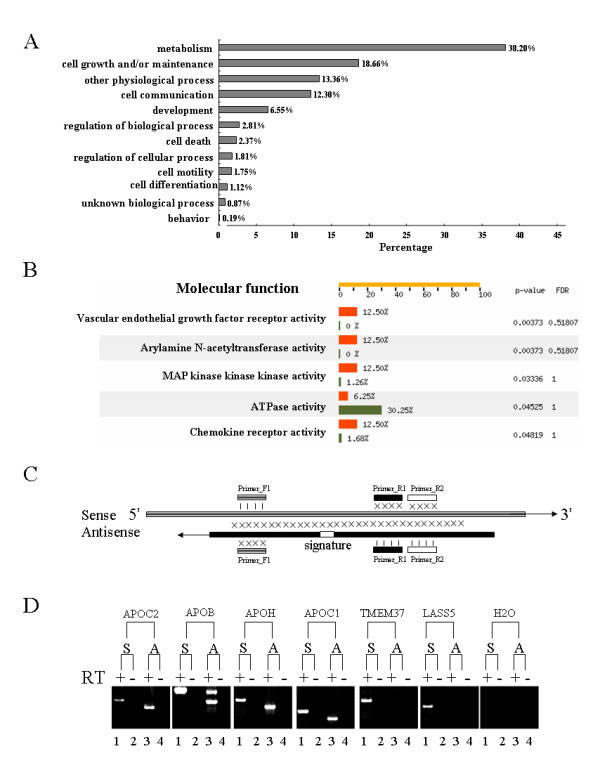
Functional categories of genes with antisense transcripts and confirmation of sense-antisense pairs of various genes expressed in human hepatocytes. A. Genes with antisense transcripts were assigned into different functional categories according to the Gene Ontology (GO) database. B. Functional over- or under-representation of GO subcategories in genes with antisense transcripts was statistically analyzed using FatiGO+ classification tool, as compared to genes without detectable antisense transcripts (p < 0.05). Red boxes indicated the GO subcategories related to genes with antisense transcripts; Green ones indicated the subcategories related to genes without detectable antisense transcripts. C. Sketch map of specific PCR primers designed for detecting both sense and antisense of various genes. The cross signs between antisense and sense transcripts represent complementarity each other, whereas the vertical bars indicate identical base pairs. Reverse transcription was performed using the specific primers (Primer_F1 for the antisense transcripts) that only hybridize to the sense or antisense transcripts. D. The sense and antisense transcripts of APOC2, APOB, APOH, APOC1 were amplified by RT-PCR using specific primers, where primers F1 and R2 were used for the sense transcripts (lane 1) and primers F1 and R1 for the antisense transcripts (lane 3). Lanes 2 and 4 were negative controls without cDNA synthesis (with DNase-treated total RNA). The two genes (TMEM37 and LASS5) without antisense counterparts were served as the set of negative control.